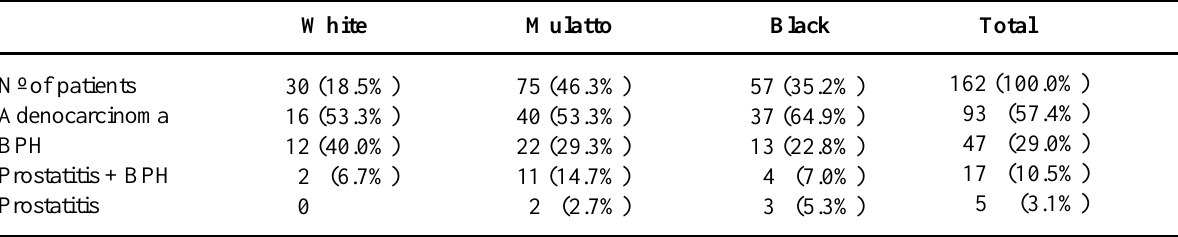
Table 3 – Histological diagnosis of 162 patients submitted to prostatic